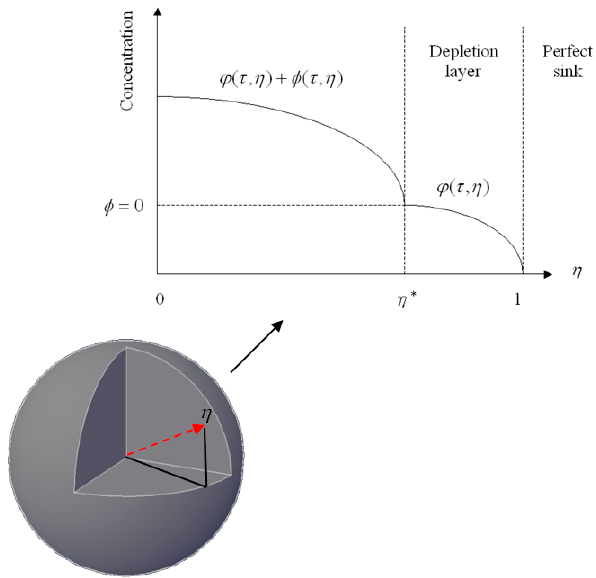
Figure 1. A schematic diagram of the drug concentration profile in a sphere immersed in an infinite medium.